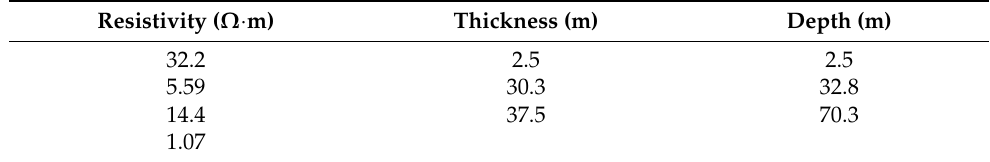
Figure 6. Value adjustment curve of VES N ◦ 15. Table 3. Results for VES N ◦ 15 analyzed with